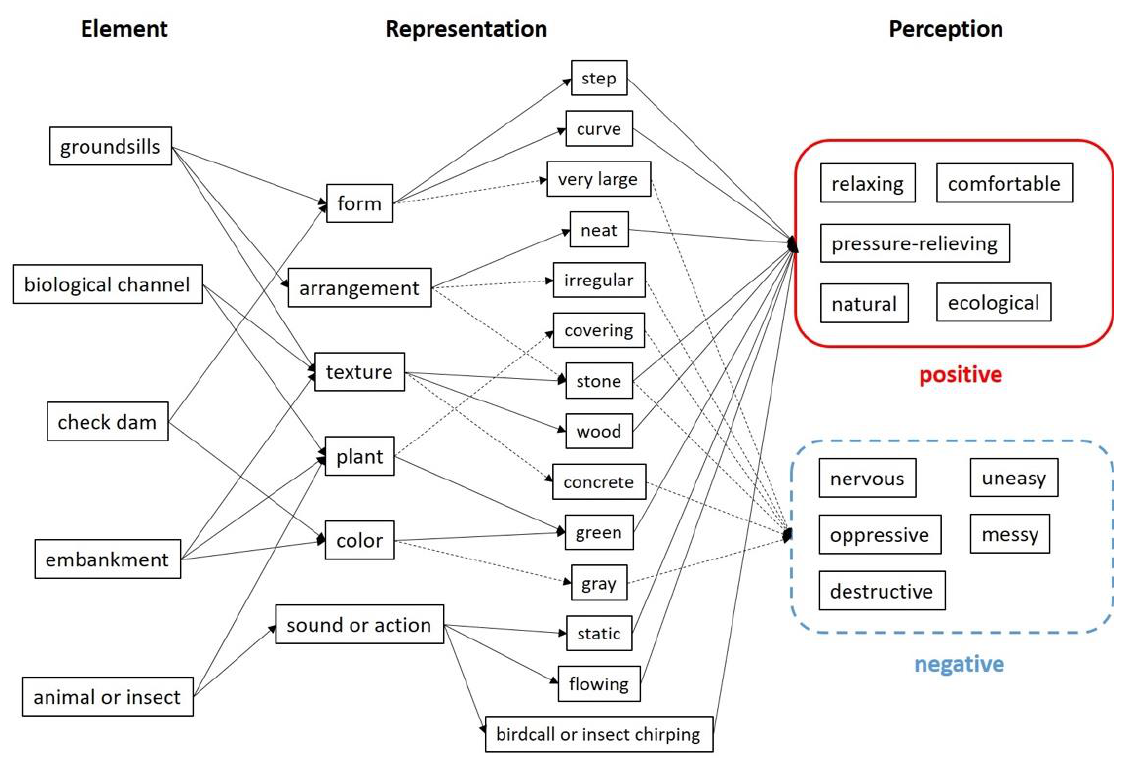
Figure 5. Interviewee consensus map (solid lines represent positive; dashed lines represent negative). Table 7. Evaluation factors of element, representation, and perception.